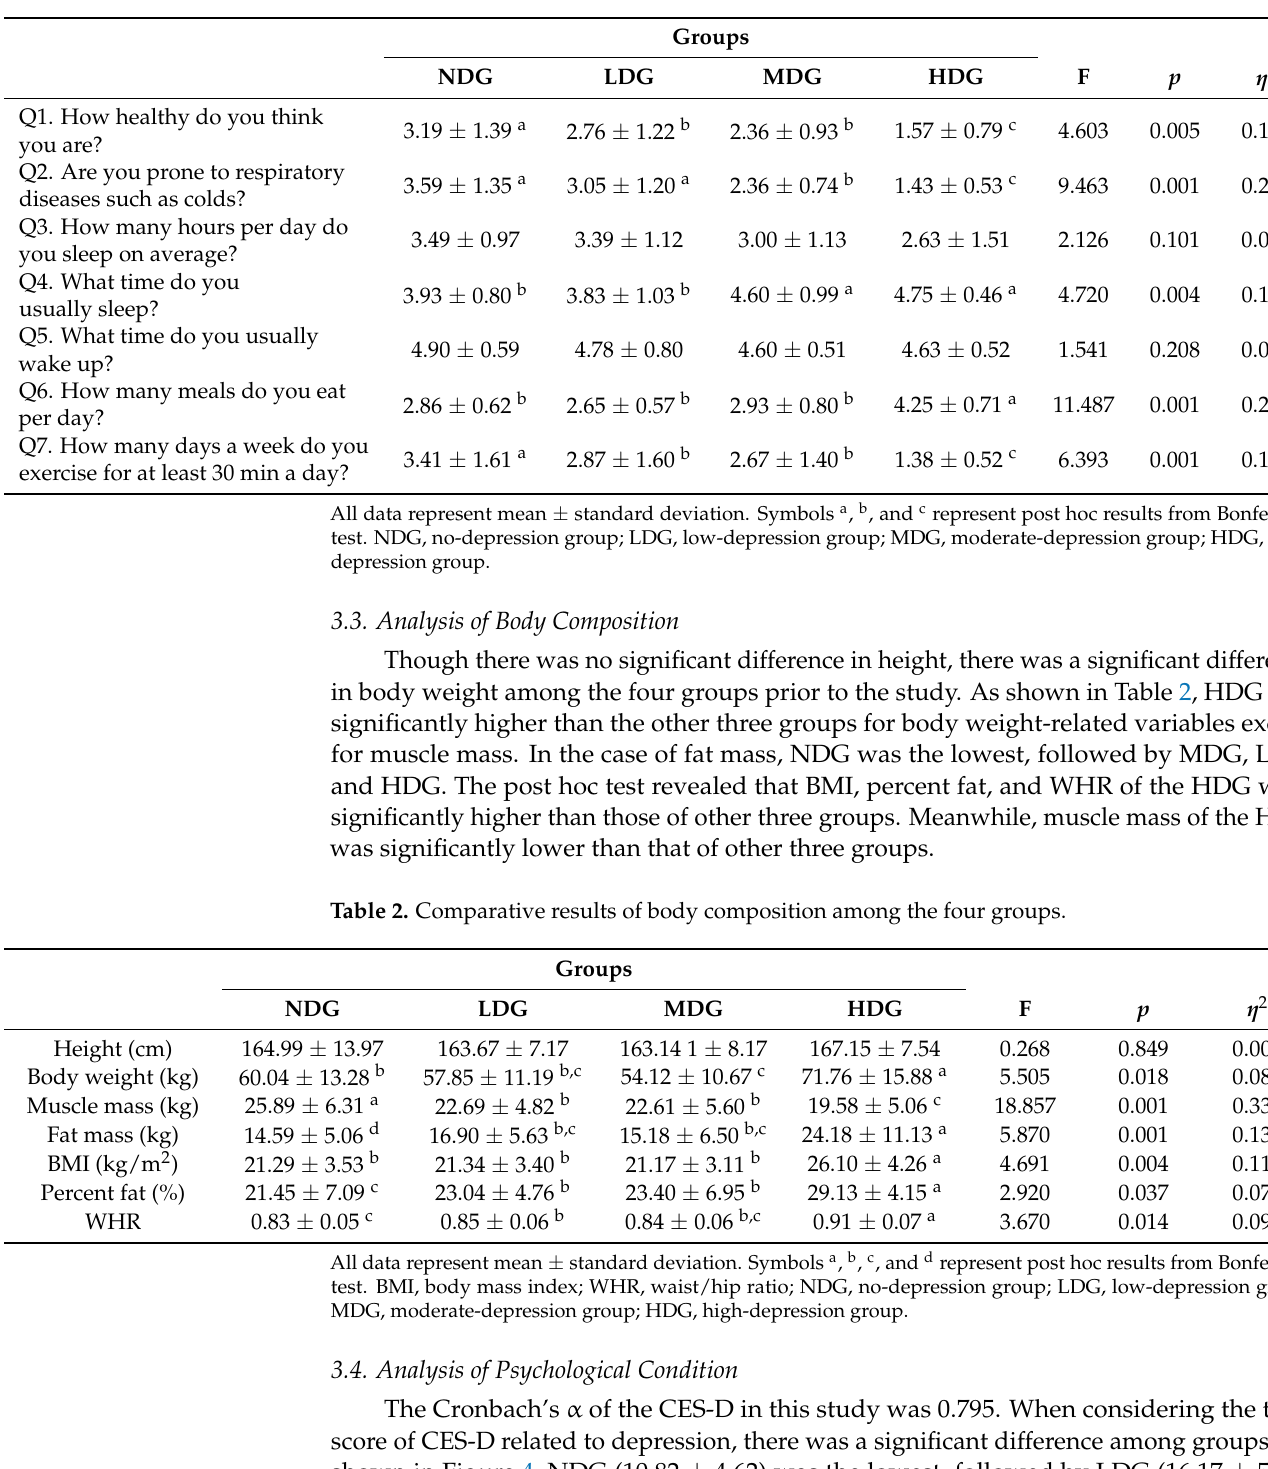
Table 1. Comparative results of daily life patterns among the four groups.